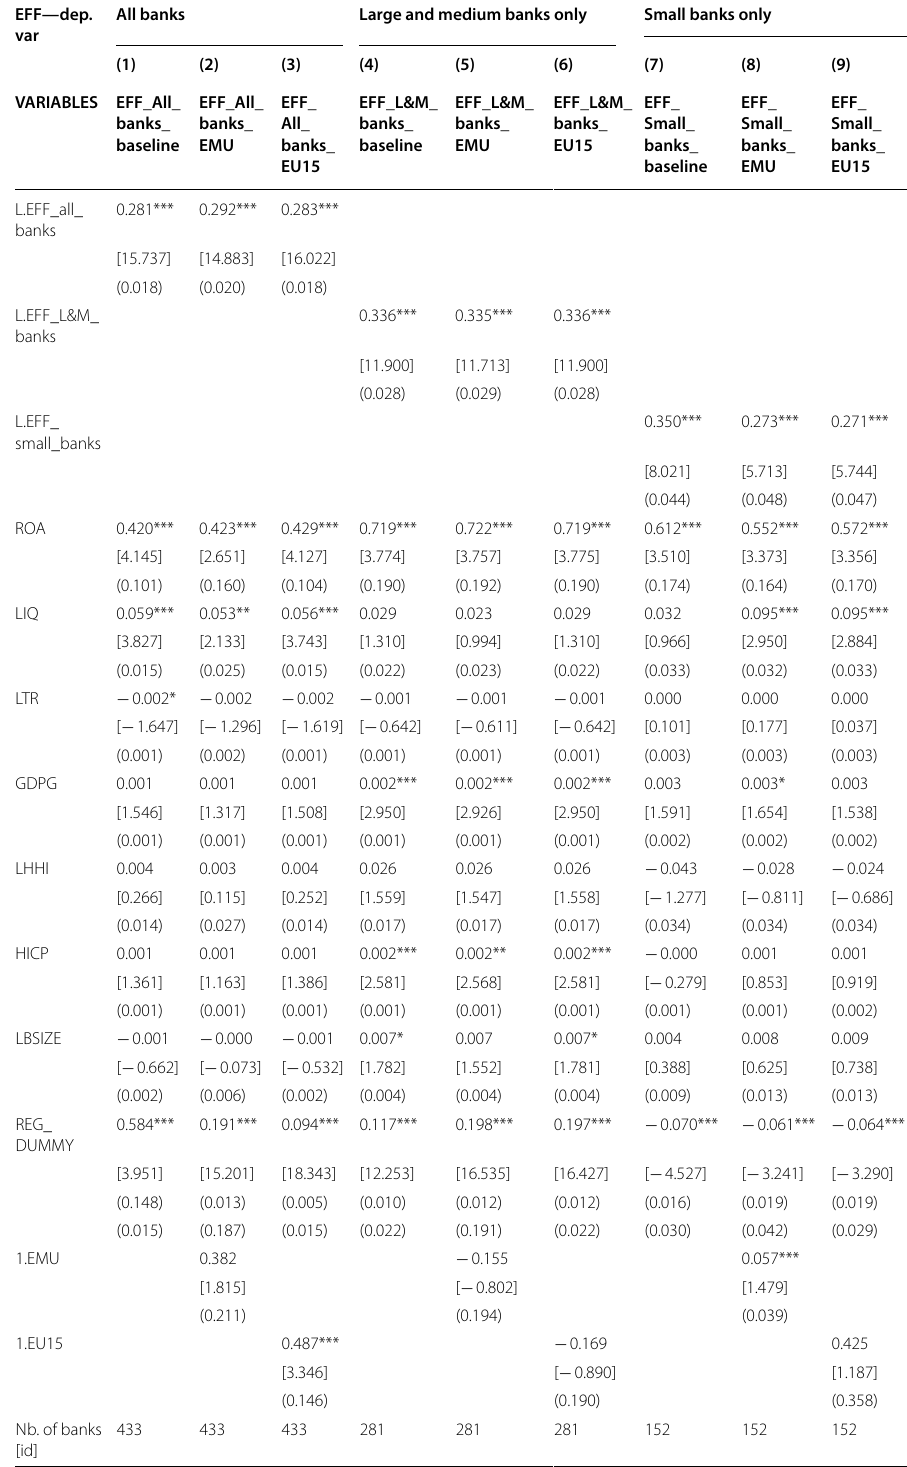
Table 8 Bank relative efficiency determinants (for all banks jointly and separately for categories of banks with respect to their size) EFF—dep.